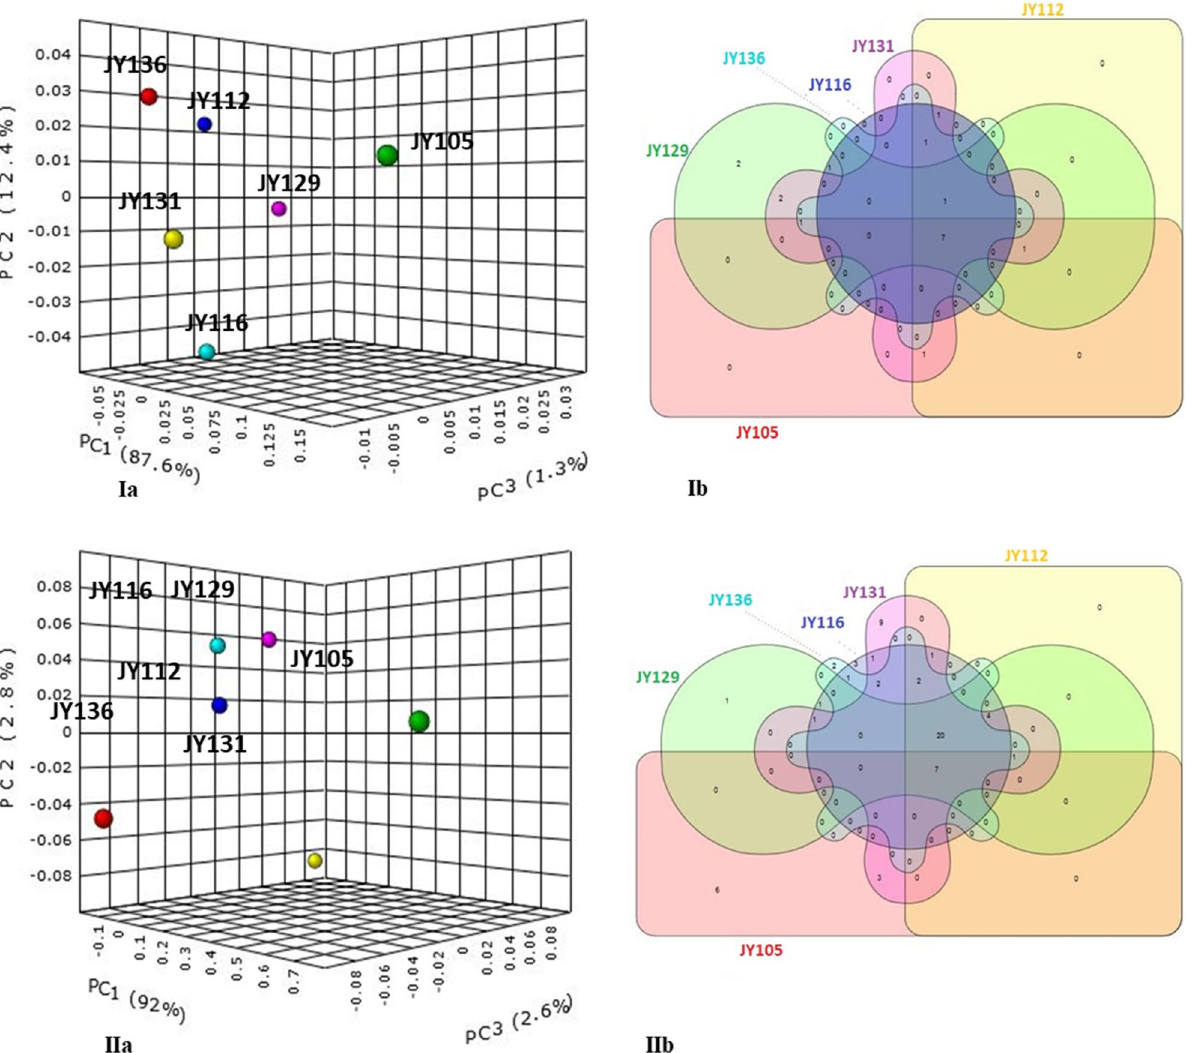
Figure 4. Bacterial diversity among different Pichia sp for intra-genera comparison of yeast strains; ( Ia , Ib ) PCoA plot and Venn diagram of bacterial phyla distribution in yeast, ( IIa , IIb ) PCoA plot and Venn diagram of bacterial genera distribution in yeast. Other details in Fig. 3. Summary of common and unique bacterial taxa derived from Venn diagram is explained in Tables S3 and heatmaps (Fig. 2a,b). The maximum number (5539) of OTUs was seen for P. kudriavzevii JY131 whereas the least (218 reads) was found in C. tropicalis JY106. Alpha diversity using the Chao-1 index and T-test/ANOVA sta- tistical method (Fig. 5Ia,IIa) and beta diversity using Bray–Curtis index and PERMANOVA statistical method were examined (Fig. 5Ib,IIb) to validate our diversity analysis. Several unclassified reads were also detected at various taxonomic levels, with unclassified bacterial reads at phylum level contributing to significant abundance in strains JY106 (27%), JY109 (13%), JY110 (18%) and JY119 (33%) which would either need further analysis or corroboration. Firmicutes (~ 45%) remain the dominant phylum followed by Proteobacteria (~ 25%) and Actinobacteria (~ 22%) for all the yeasts examined in this study (Figs. 1a, 2a). At the genus level, major differences in the abun- dance were observed (Figs. 1b, 2b). Only a few bacterial genera were common among certain groups of yeast strains, as shown by the clustering of these samples in the PCoA plots (Fig. 5IIb). Reads of the genus Streptococcus contributed the greatest number of OTUs in all yeast strains, with the maximum number in C. metapsilosis strain JY103 (~ 34% of their total OTUs) and the minimum in C. suratensis strain JY121 (~ 4% of their total). Strain JY119 was the only strain that did not possess any Streptococcus reads. It had notably different read composi- tion from the rest of the yeast strains where Acidobacteria (236 OTUs) was the most dominant phylum. Also, JY119 showed lesser richness of bacterial diversity as against the majority of the yeast strains. Planococcus reads dominated in strains JY112, JY116, JY121, JY124, JY125, JY129, JY130, JY131, JY133, JY134 and JY136 with the maximum number of OTUs in Candida suratensis strain JY124 (~ 20% of their total) and the minimum in P. kudriavzevii strain JY131 (~ 11% of their total). OTUs of unclassified Clostridiales were only observed in P.